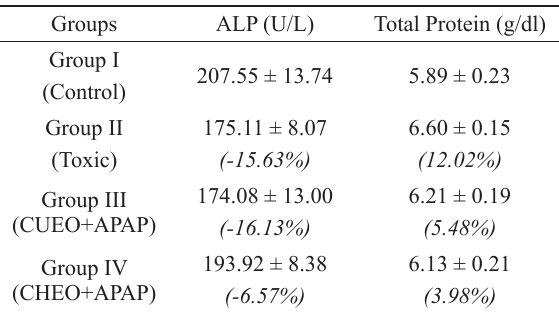
Effects of 2-week treatment with CUEO or CHEO on serum levels of ALP and total protein in APAP-intoxicated